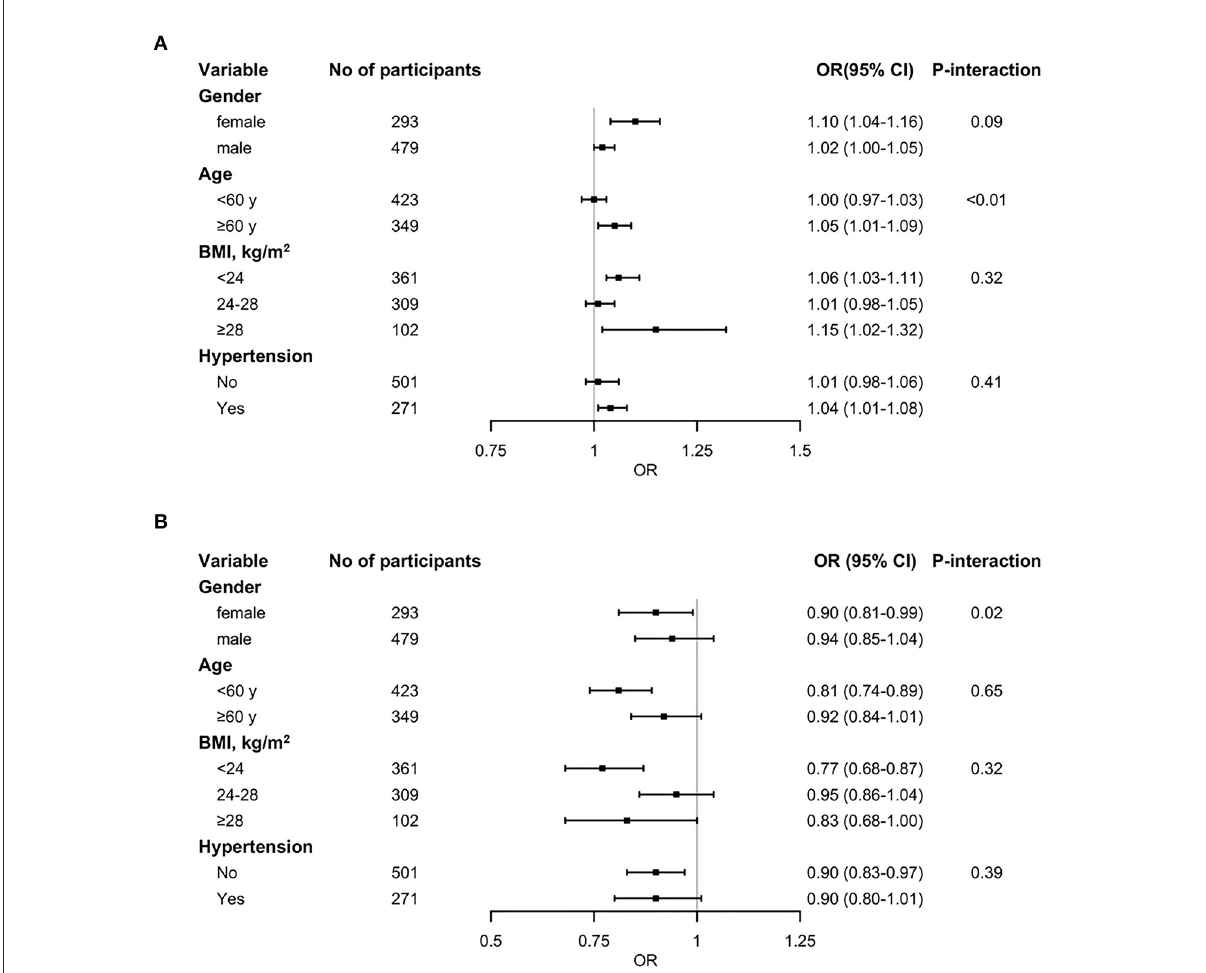
FIGURE3 Stratified analysis of the association between circulating homocysteine (A) and folate (B) concentrations and T2DM. The black squares denote ORs for T2DM risk and the horizontal line signify 95% CI ( n = 772). Models were adjusted for age, sex, body mass index, smoking history, drinking history, hypertension history, fasting total cholesterol, triglycerides, HDL cholesterol, LDL cholesterol, and glucose levels. P-interaction means the P value of the multiplicative